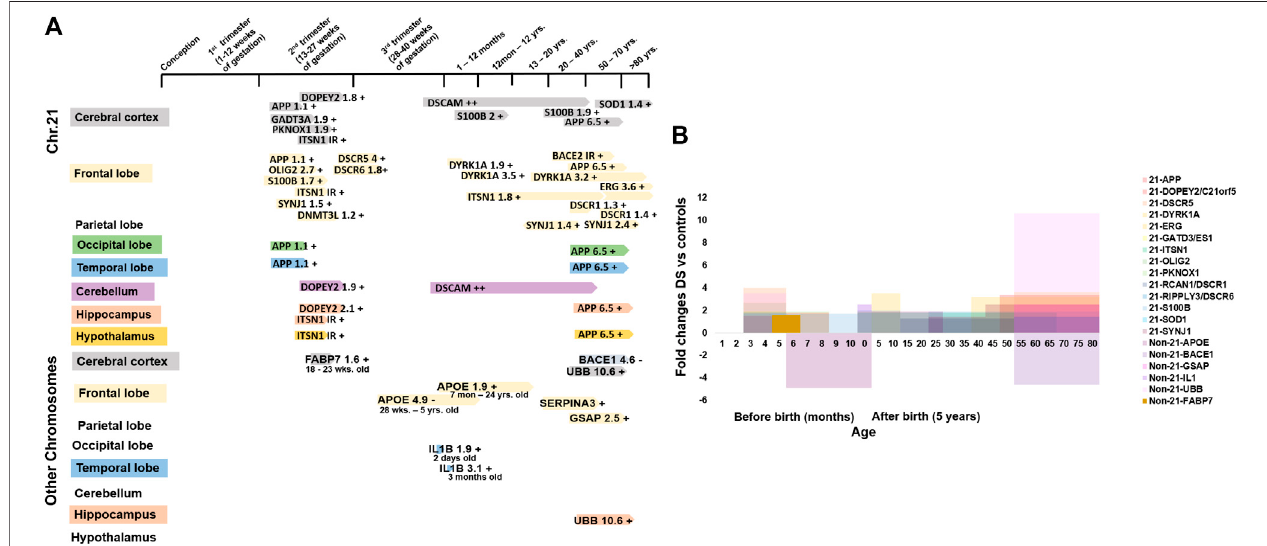
FIGURE4| MolecularchangesinhumanDownsyndromebrains. (A) Timelineofstudiedbraindevelopmentgenesduringdevelopmentinchromosome21(Chr21, upperpanel)andotherchromosomes(non-Chr21,lowerpanel)inbrainswithDS.+/-=increase/decreaseexpressionlevelscomparedtonormalcontrolbrains. (B) Fold changes of studied brain development gene expression in Chr21 & non-Chr21 in brains with DS. Mean change data is extracted from available literature as shown in Table 1